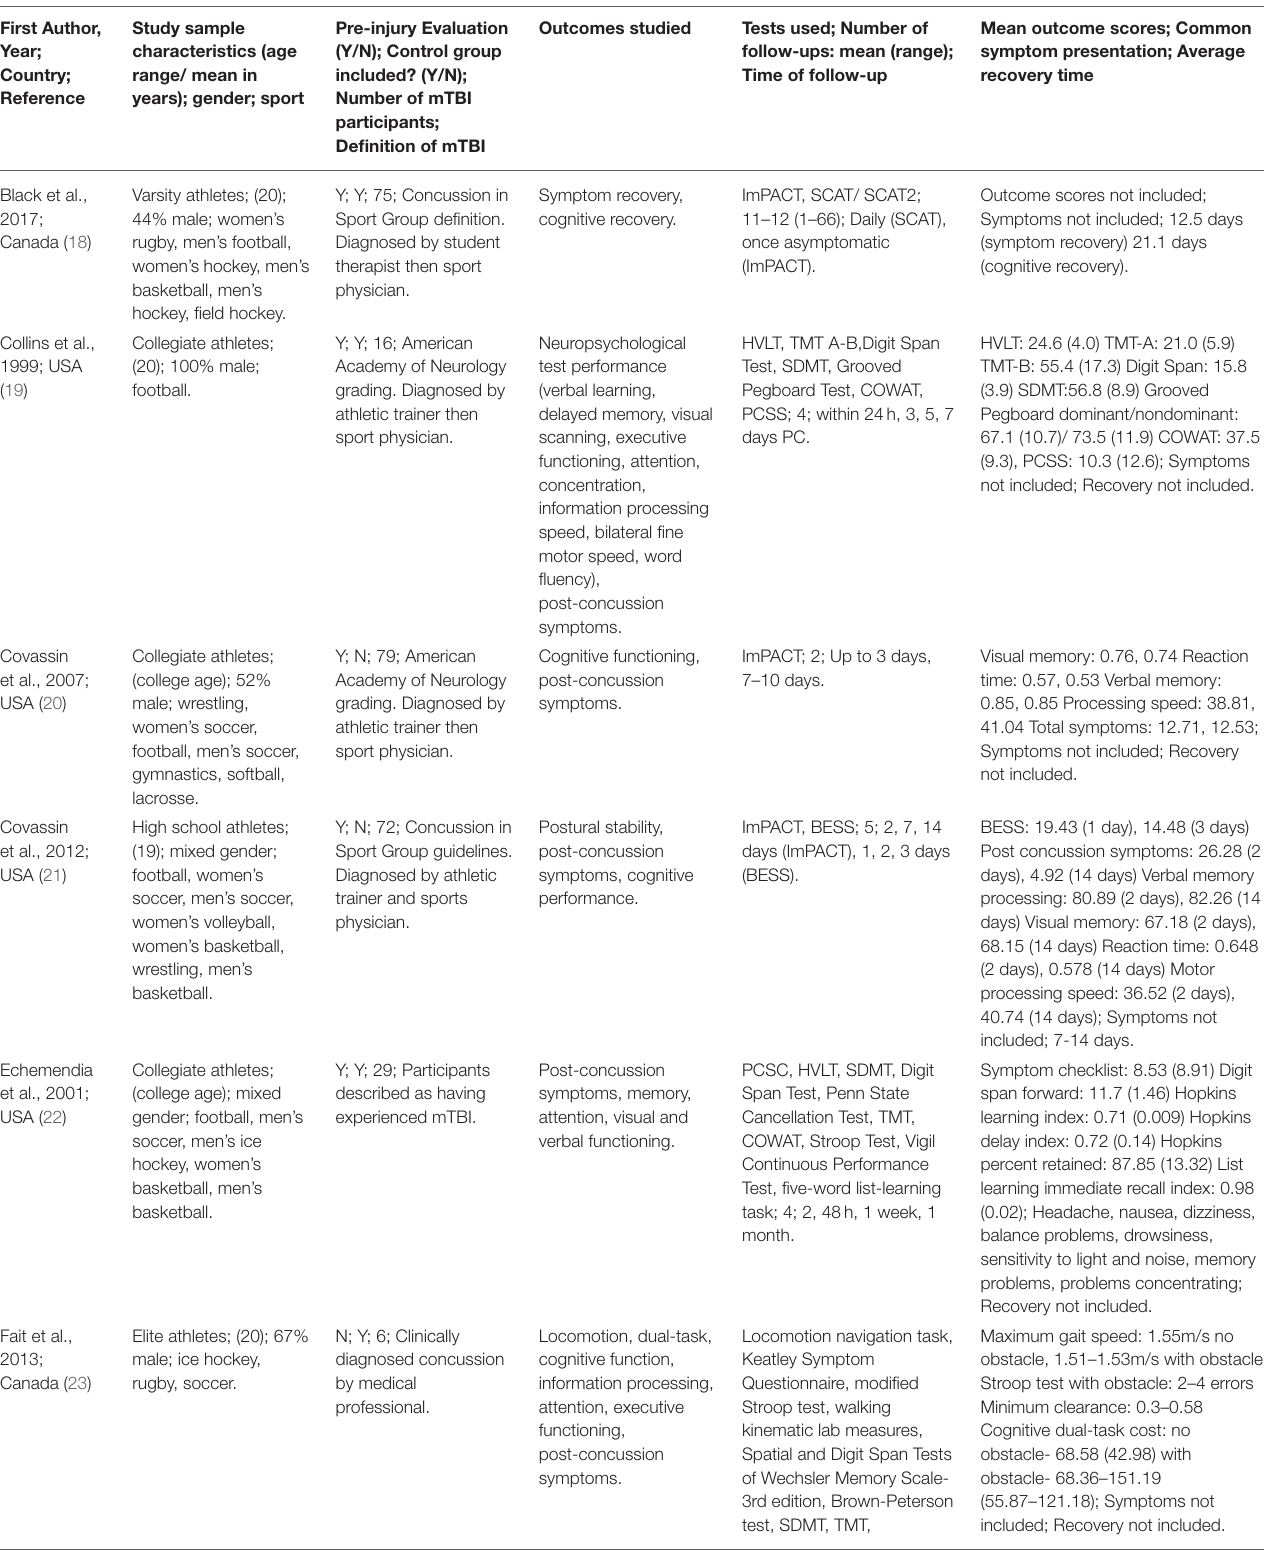
TABLE 2 | Sports-related